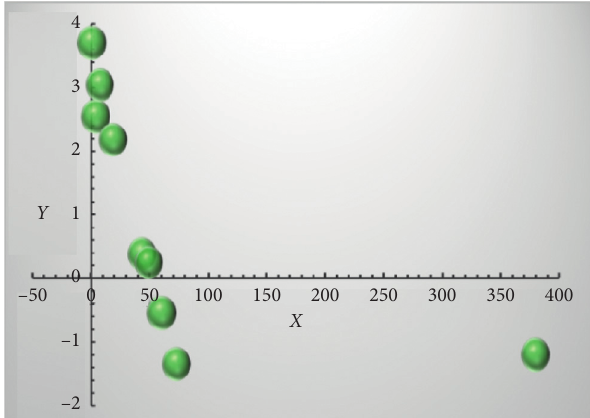
Figure 13: Scatter diagram after linearization of 9